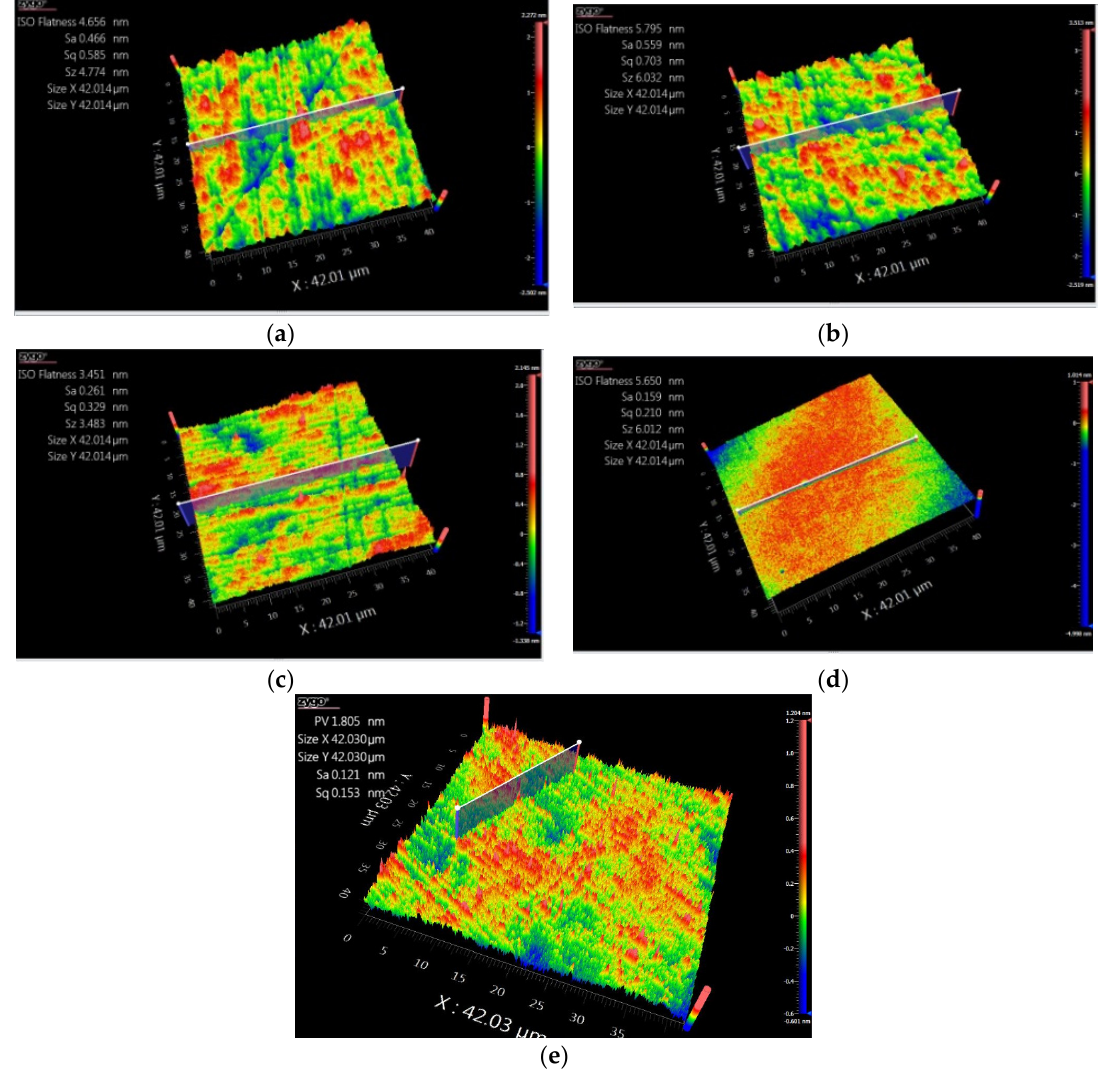
Figure 5. Zygo images of the SiC surface formed after polishing using pads impregnated with ( a ) 1 wt % Fe particles, ( b ) 1 wt % Al 2 O 3 particles, ( c ) 1 wt % Fe and 1 wt % Al 2 O 3 particles, and ( d ) 1 wt % Fe particles and 3 wt % Al 2 O 3 particles. ( e ) Image of the SiC surface when using the traditional polishing pad.